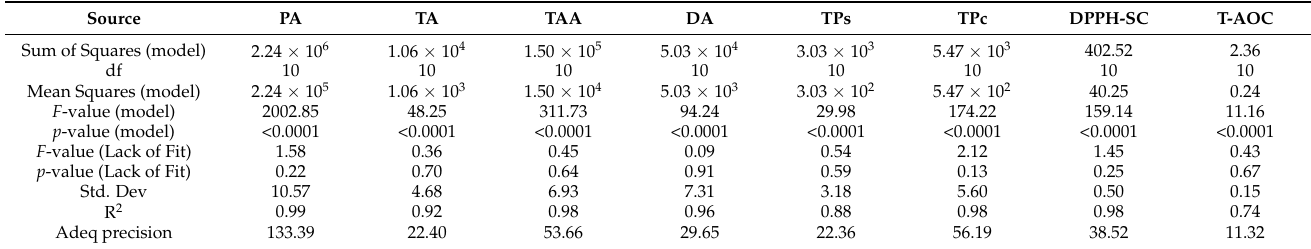
Table 2. ANOVA analysis for the response surface